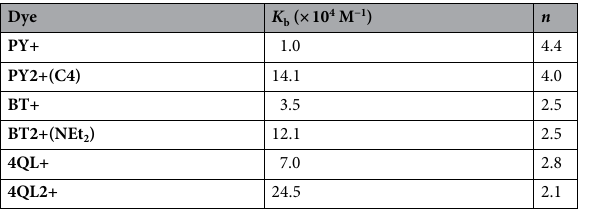
Table 2. Binding constant ( K b ) and the number of dsDNA base pairs occupied by one bound dye molecule ( n ) values of the synthesized styryl dyes. Conditions: [Dye] = 2 μM, [DNA (in bp)] = 0.3–3 μM; all measurements were performed in 10 mM sodium phosphate buffer pH